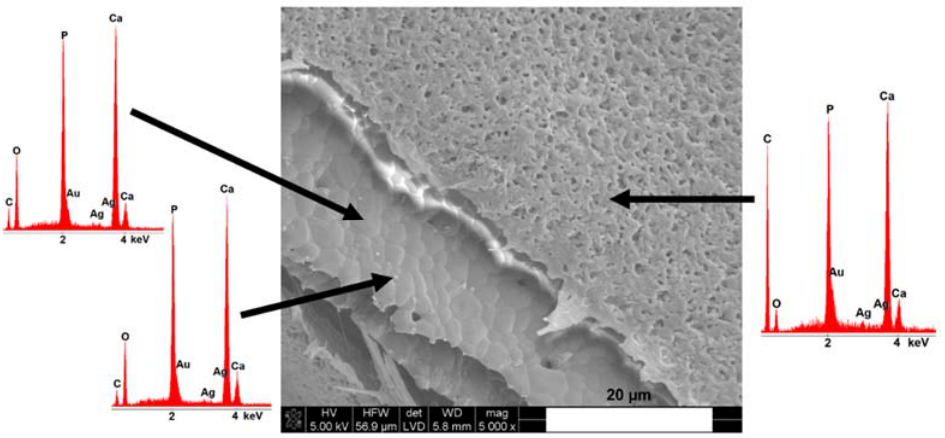
Figure 4. SEM microphotograph and energy-dispersive X-ray spectroscopy (EDS) analysis of the scaffold covered with poly(3hydroxybutyrate) (TCP/P(3HB)).